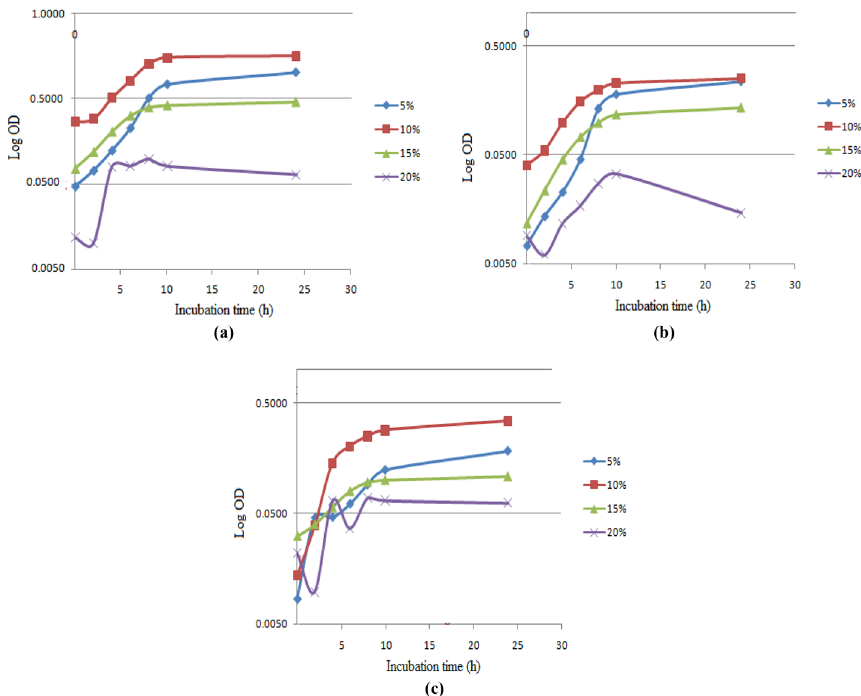
Fig.1 Optimum molasses fermentable sugar concentration for the growth of a . Bacillus paramycoides b . Citrobacter sedlakii c . Enterobacteer bugadensis